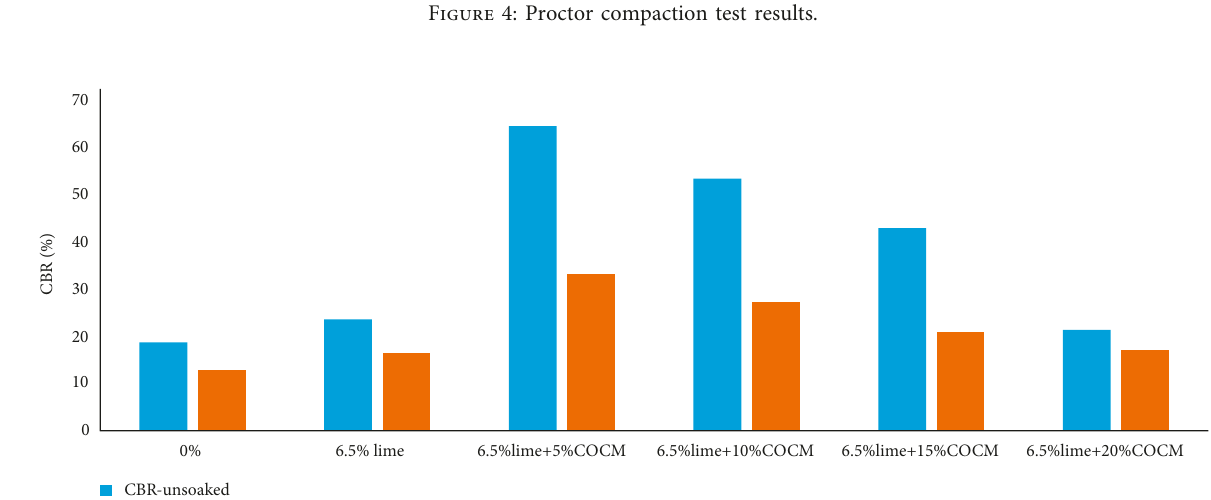
Figure 4: Proctor compaction test